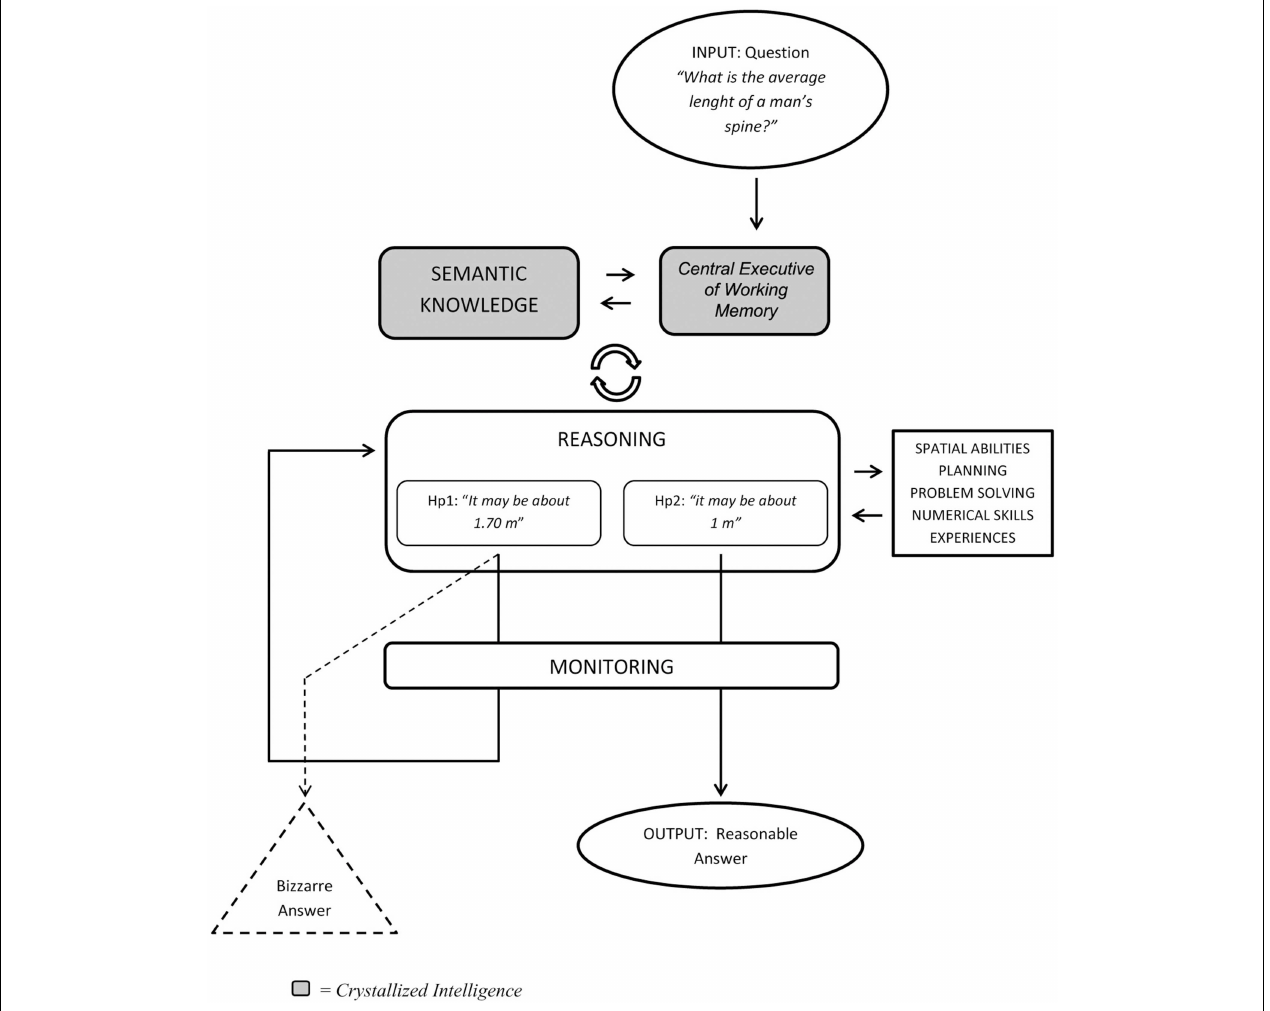
FIGURE 1 | Model of the cognitive estimation